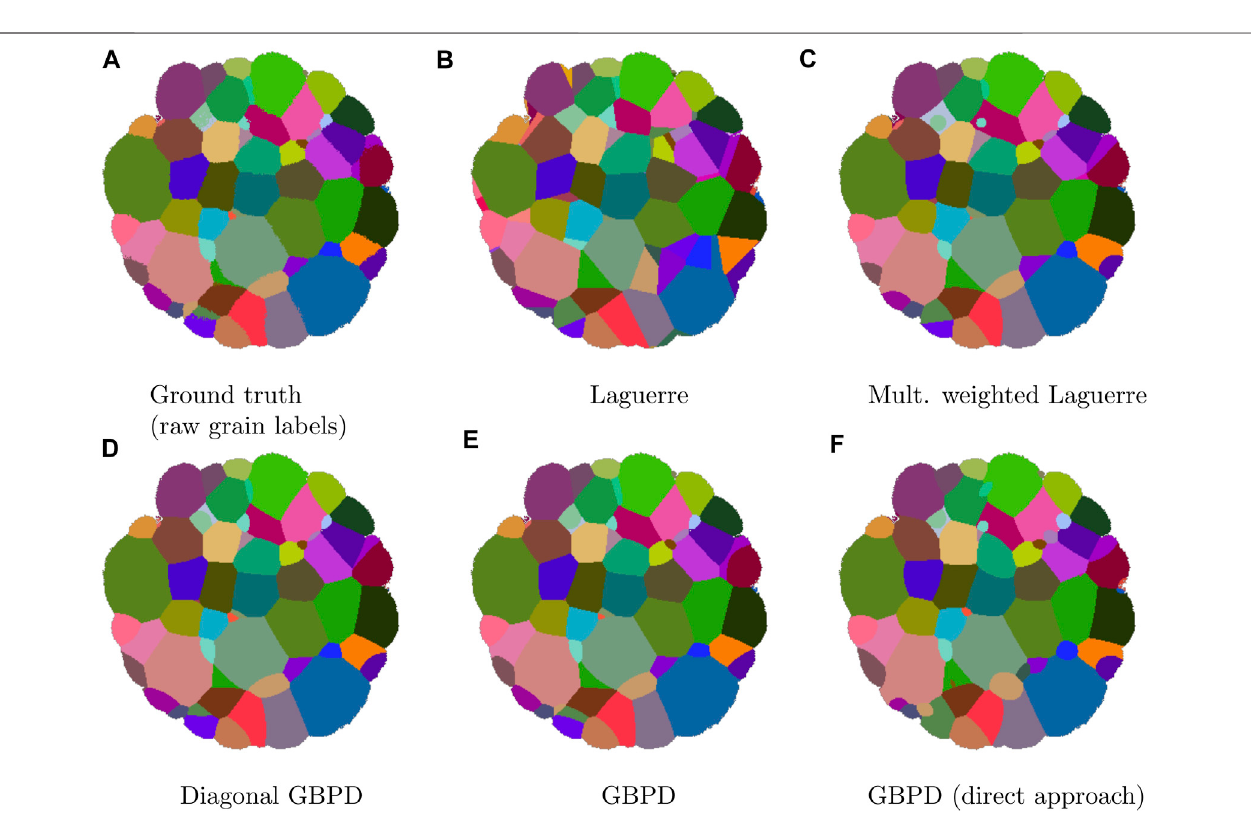
FIGURE 9 | Two-dimensional slices through (A) the raw experimental ground truth image data and (B) – (F) the corresponding fi tted tessellations. The fi ts in (B) – E) were obtained by the gradient descent-based method described in Section 2.3 , whereas (F) followed from the direct approach described in Section 2.4.2 . Note that the 2D slice shown in (A) differs from that shown in Figure 1A